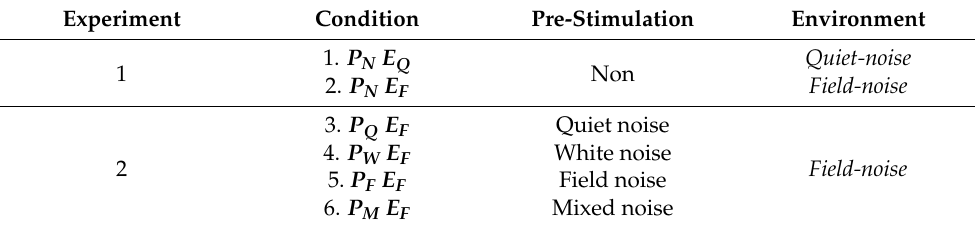
Table 1. Experimental conditions for Experiment 1 and Experiment 2 .